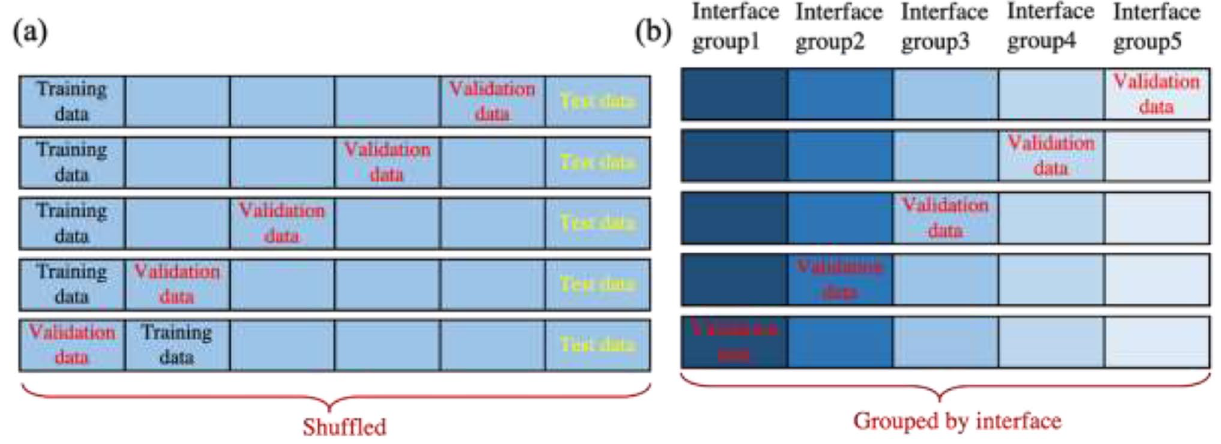
Figure 1. Schemes for ( a ) shuffled cross-validation and ( b ) grouped